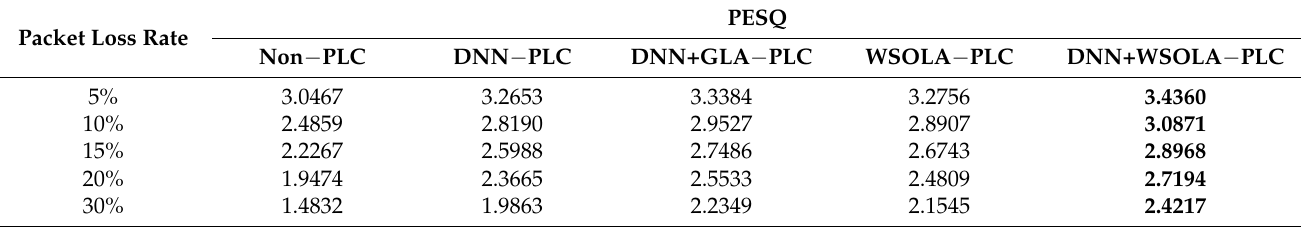
Table 1. PESQ results.